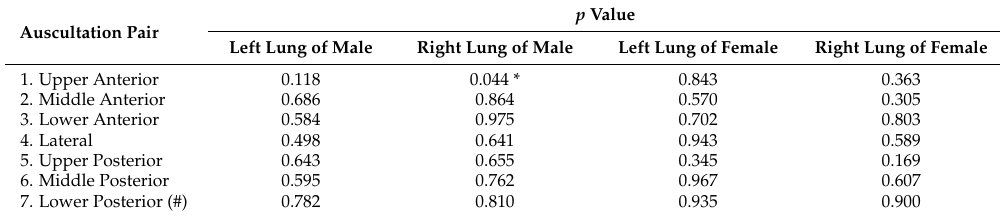
Table 2. Linear regression analysis of the correlation between body height and P T of lung sound at each auscultation site for male ( n = 24) and female ( n = 18)